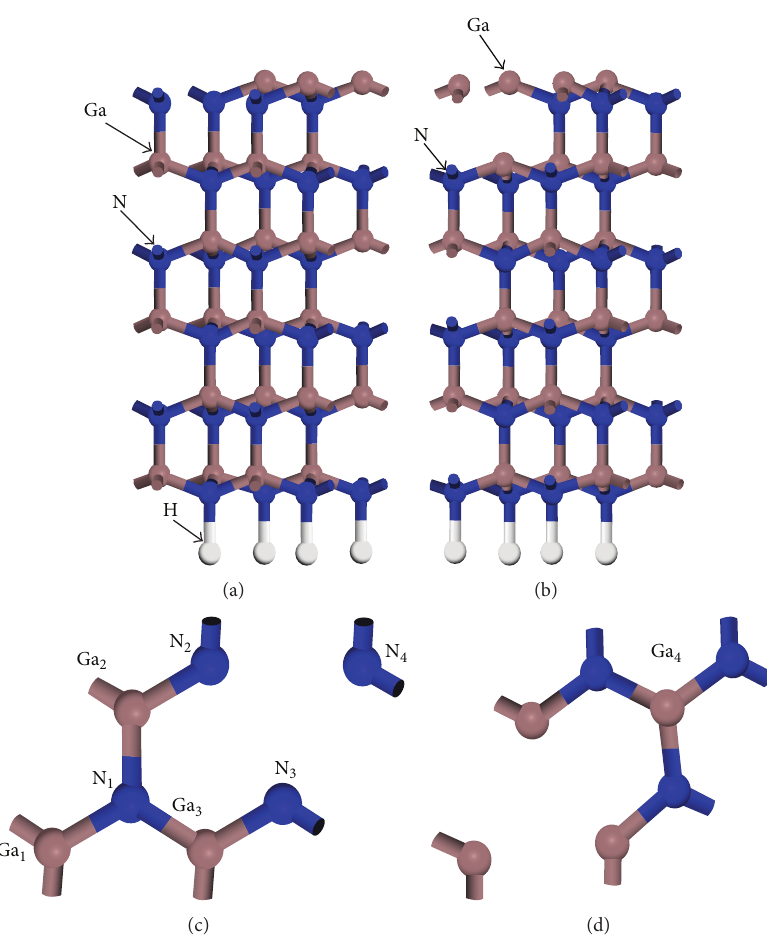
Figure 1: 2 × 2 GaN(0001) surface: (a) side view of Ga vacancy defect surface, (b) side view of N vacancy defect surface, (c) top view of Ga vacancy defect surface, and (d) top view of N vacancy defect surface. Ga and N atoms are marked.